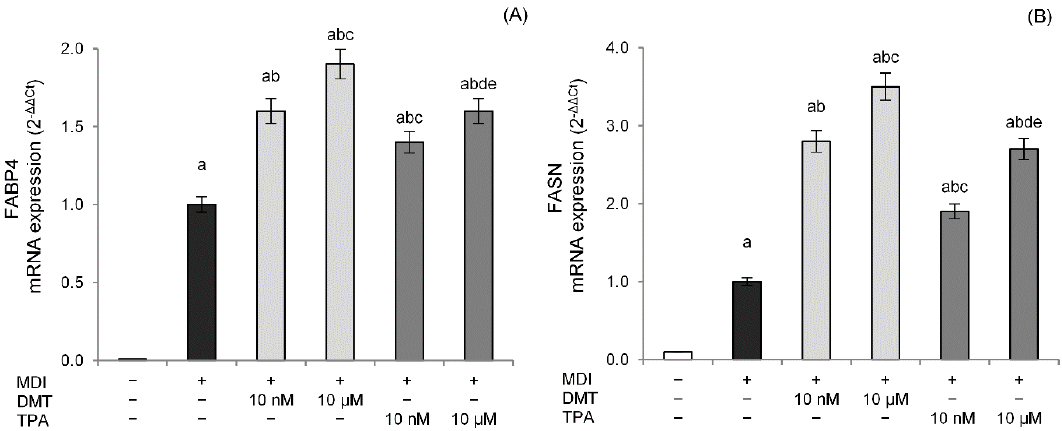
Figure 4. Effect of p-phthalates on FAPB4 ( A ) and FASN ( B ) mRNA expression. 3T3–L1 preadipocytes were cultured in differentiation medium (MDI) containing p-phthalates (10 nM and 10 µ M) for 10 days. Cells treated with MDI alone were used as controls. Undifferentiated cells were cultured in standard medium for 10 days. FAPB4 and FASN mRNA expression was analyzed by real-time PCR and data are expressed as 2 −ΔΔ Ct and normalized to MDI. 18S rRNA was used as housekeeping gene. All data are expressed as mean ± SD of three independent experiments. a p < 0.05 vs. undifferentiated cells; b p < 0.05 vs. MDI; c p < 0.05 vs. DMT 10 nM; d p < 0.05 vs. DMT 10 µ M; e p < 0.05 vs. TPA 10